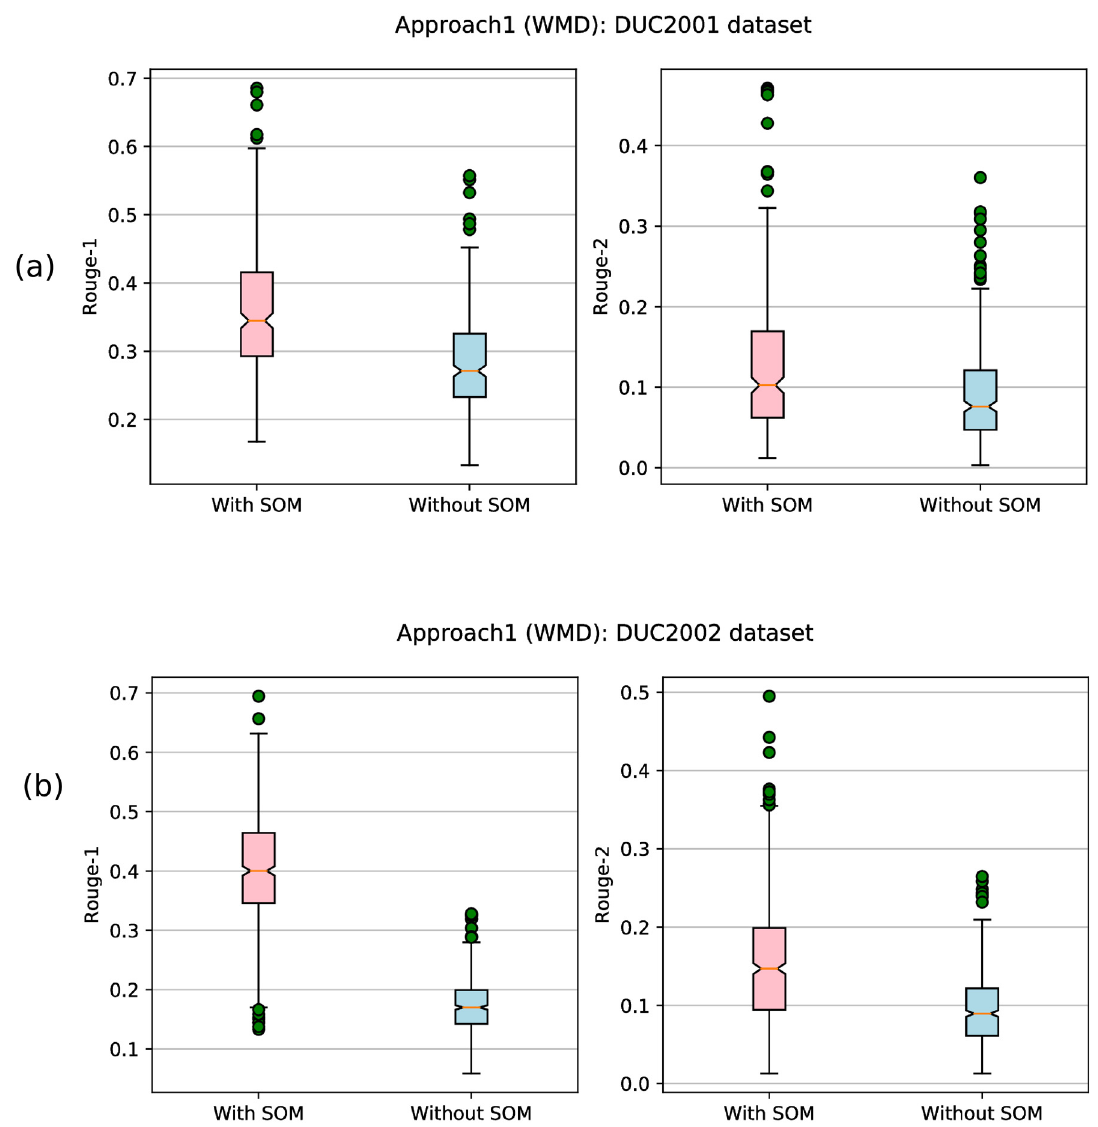
Fig 7. Box plots. Sub-figures (a) and (b) for DUC2001 and DUC2002 dataset, respectively, show the variations of average Rouge-1/ Rouge-2 values of highest ranked (rank-1) solutions in each document. In each colored box, the horizontal colored line indicates the median value of rank-1